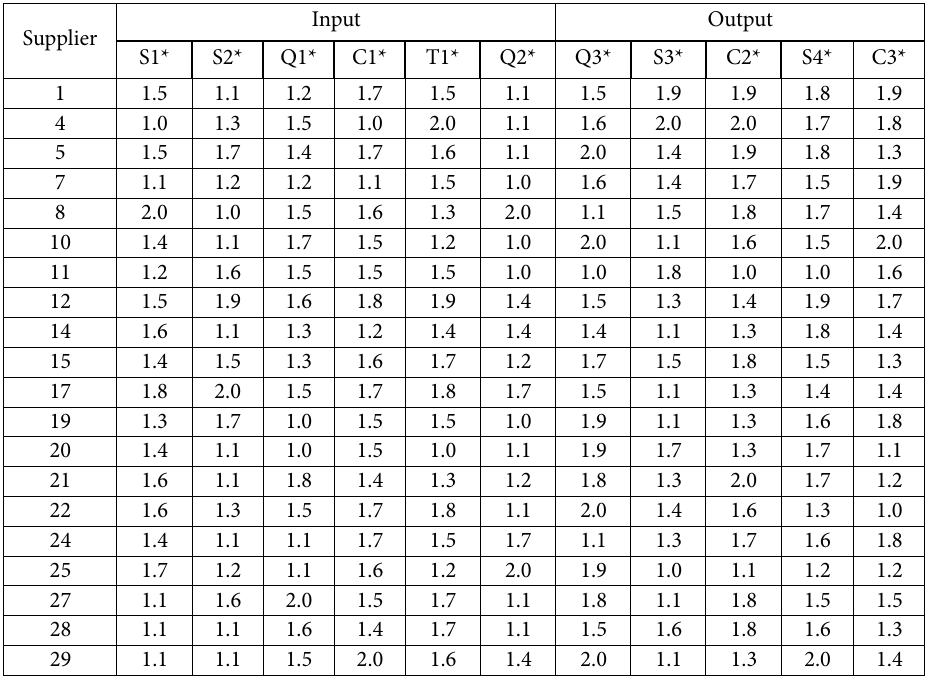
Table 9. Processed data of oil injection nozzle for the DEA approach Supplier